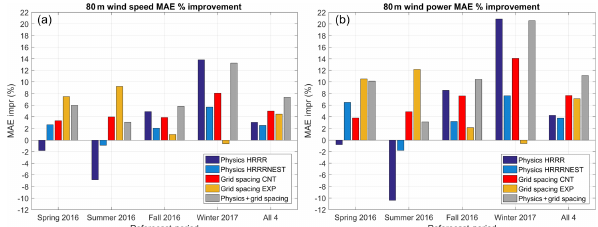
Figure 9. Panel (a) : percentage improvements on 80m wind speed MAE due to the experimental physics, finer horizontal grid spacing, and the combination of the two, for the four reforecast periods sep- arately and averaged together. Panel (b) : same as (a) , but for 80m wind power MAE results.